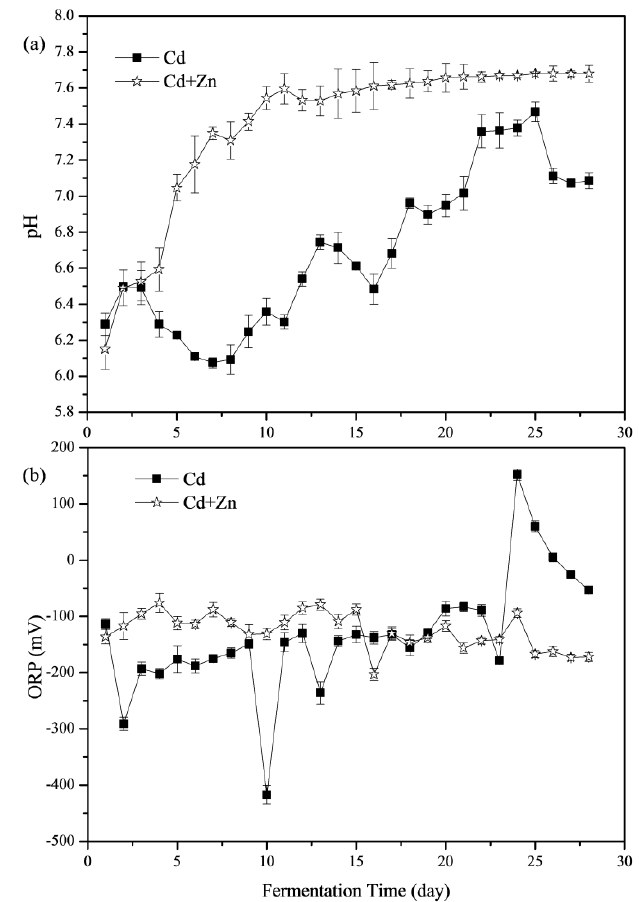
Figure 3. Impact of Cd and Cd + Zn addition on pH values ( a ) and oxidation-reduction potential (ORP) ( b ) during the fermentation.